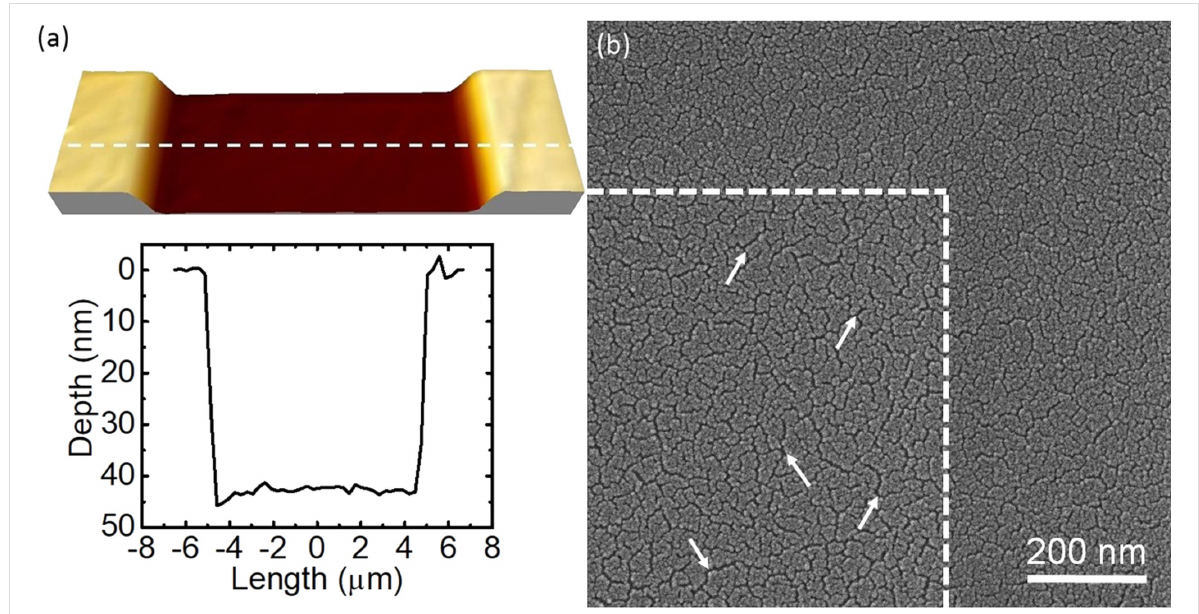
Figure 5: (a) AFM image and the corresponding depth profile of a part of the surface depression produced in a 15 nm Pt 60 Pd 40 /PC sample by irradia- tion with He + FIB at an energy of 25 keV with a fluence of 2.0 × 10 15 cm − 2 . The dashed line indicates the place of the depth profile. (b) HIM image of a part of the same depression, demonstrating the persistence of the metal film. White arrows indicate some nanoscale cracks in the Pt 60 Pd 40 film in the irradiated region. Dashed lines indicate the border between irradiated and non-irradiated regions.